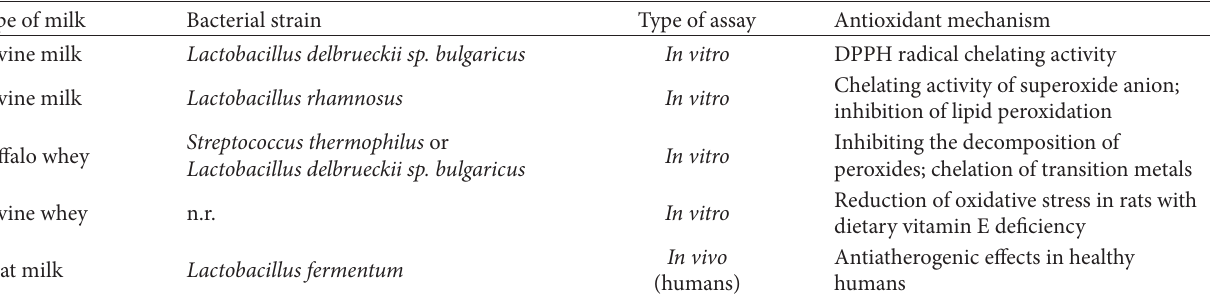
Table 2: Fermented milks with antioxidant activity